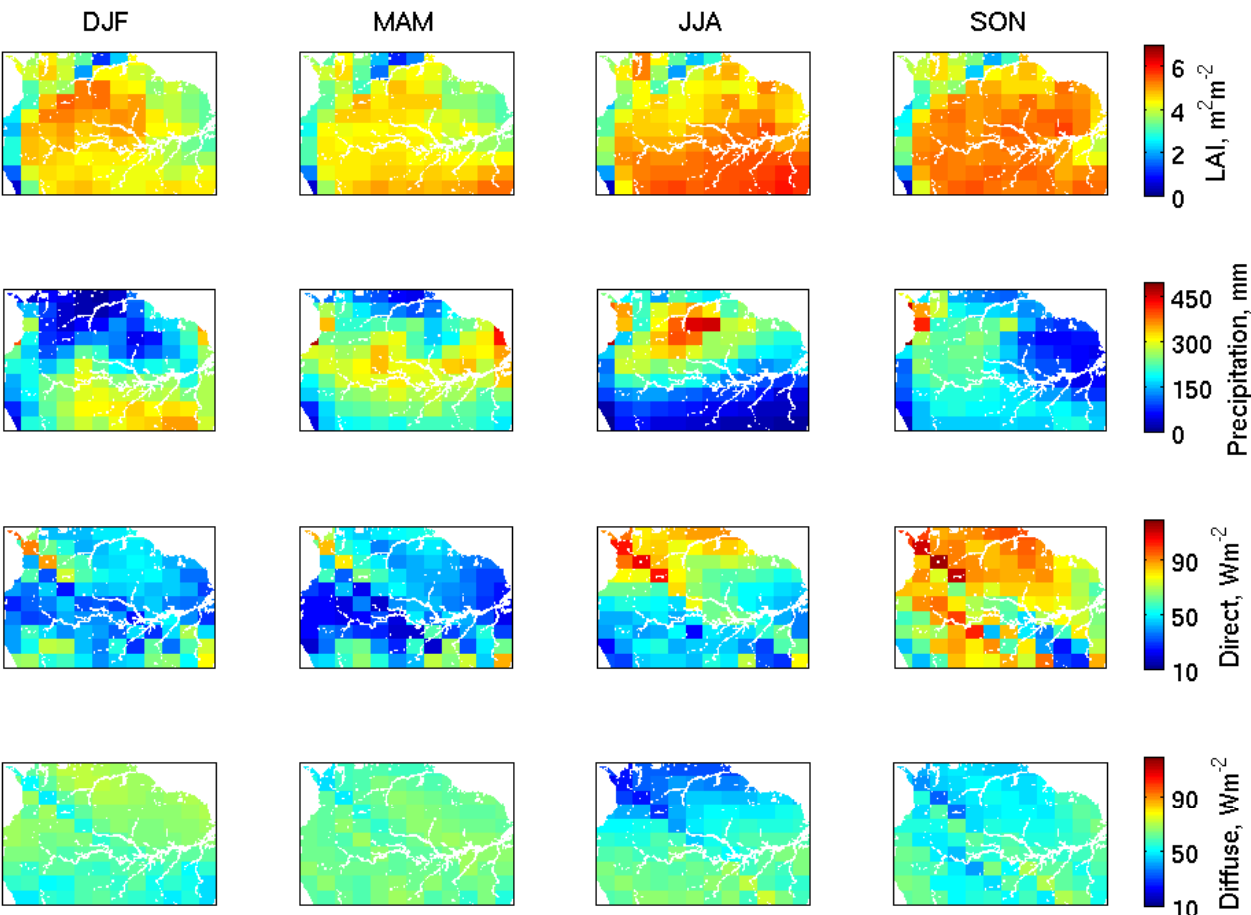
Fig. 1. From top to bottom: MODIS leaf area index (m 2 m − 2 ), WorldClim precipitation (mm) (Hijmans et al., 2005), GEOS-4 direct and diffuse photosynthetically active radiation, PAR (Wm − 2 ) across the study region. The dry season, with precipitation levels of under 100mm, runs generally from July–September, period which coincides with an increase in direct PAR due to a decrease in cloud cover. We can observe that the LAI also peaks during this period, reaching its lowest levels in the wet